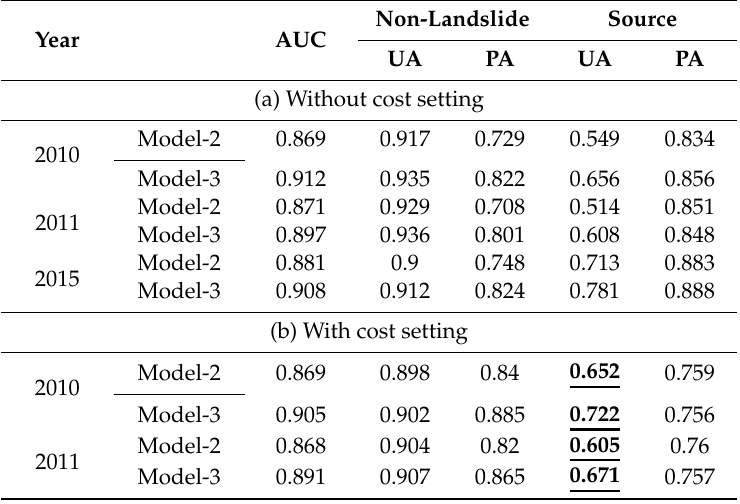
Table 8. Prediction of Model-2 and -3 using later-record